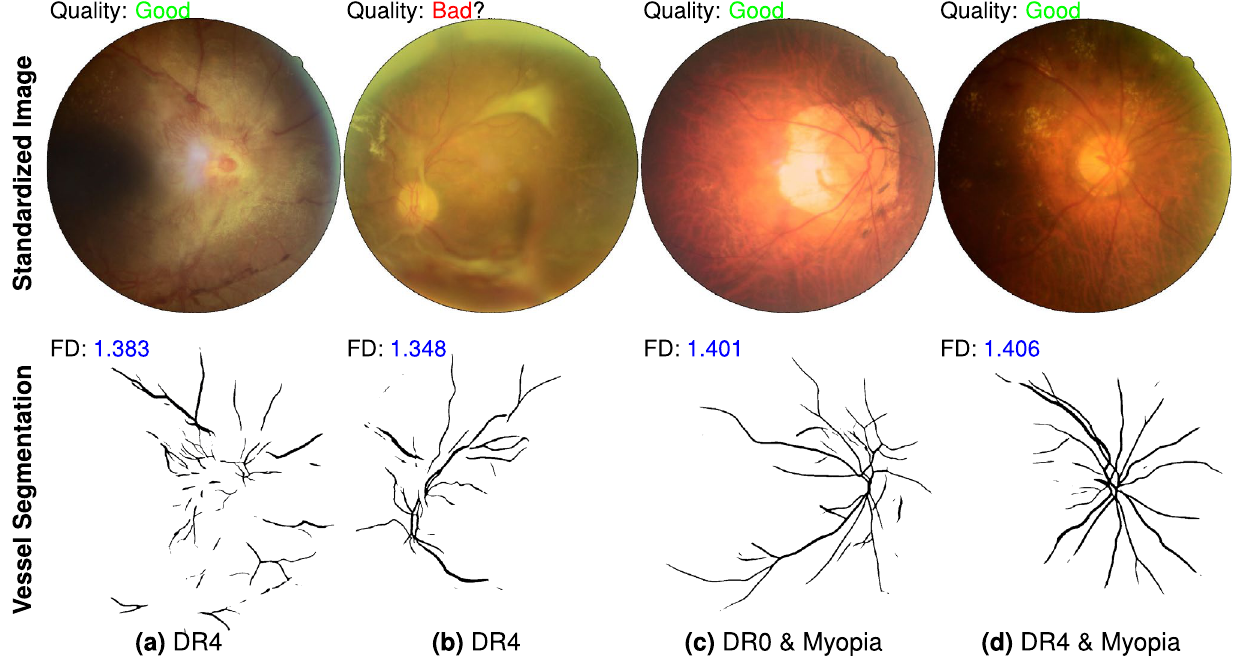
Figure 4. Failed examples caused by decreased vessel density in DeepDRiD dataset. Top row shows 4 pathological images with sufficient image quality and the second row displays corresponding vessel segmentation images predicted by our retinal vessel segmentation model. Misclassification is owing to the presence of only a few visible vessels within the FOV. The file names of color images are ( a ) “51_r1”, ( b ) “309_l2”, ( c ) “67_r2” and ( d )